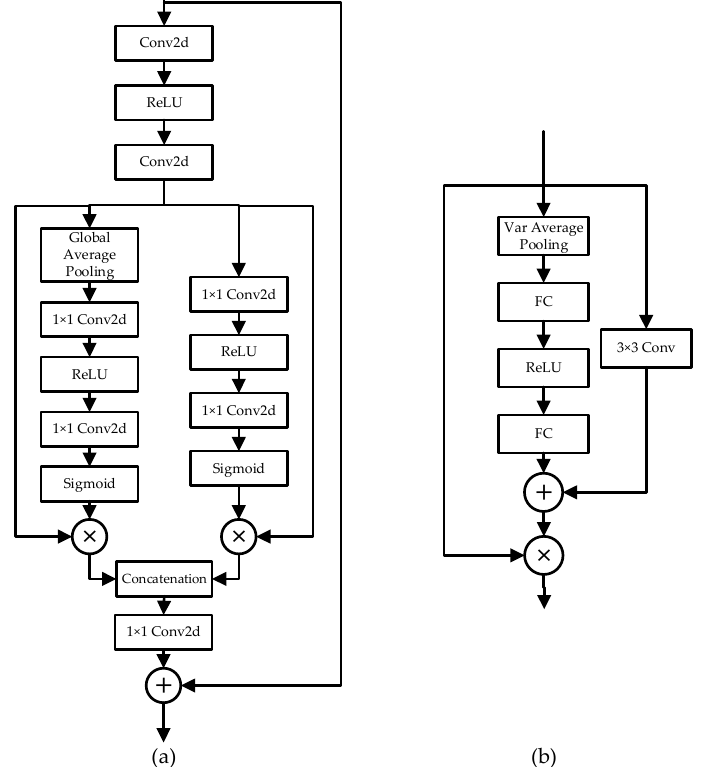
Figure 3. The detailed structure of the attention blocks, which has the combination of the two kinds of attention mechanisms. ( a ) CSAR module in CSFM, ( b ) RAM in SRRAM.